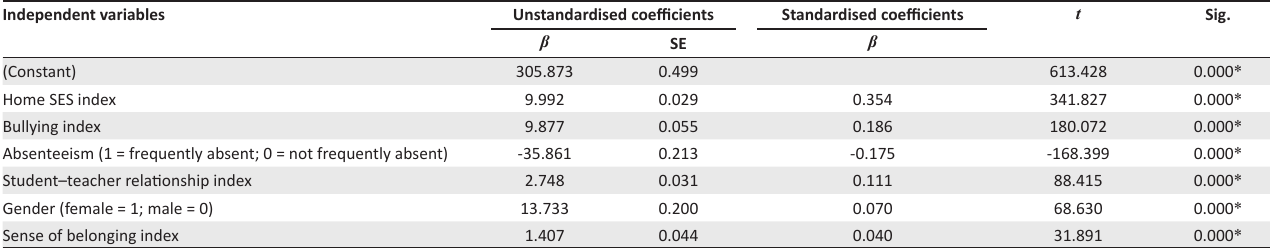
TABLE 2: Results of step 6 of the stepwise regression analysis. Independent